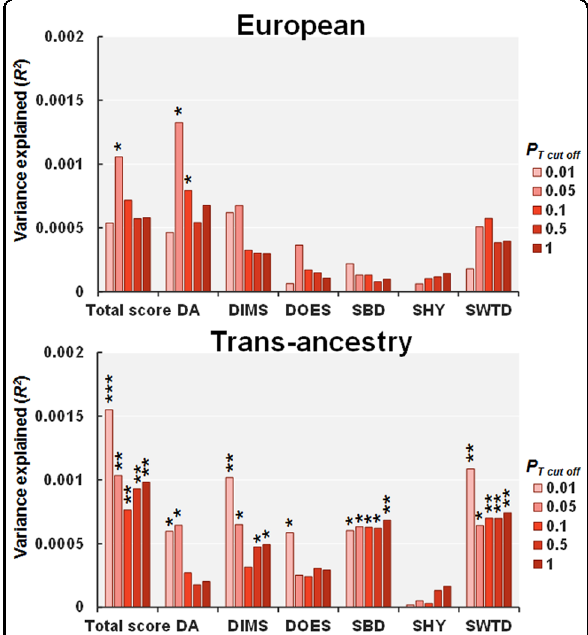
Fig. 4 Effects of PRSs for anxiety disorders on the risk of sleep disturbance in young adolescence in European children and in children of trans-ancestry. *** p < 0.001, ** p < 0.01, * p < 0.05. DA, disorders of arousal or nightmares; DIMS, disorders of initiating and maintaining sleep; DOES, disorders of excessive somnolence; SBD, sleep breathing disorders; SHY, sleep hyperhidrosis; SWTD, sleep – wake transition